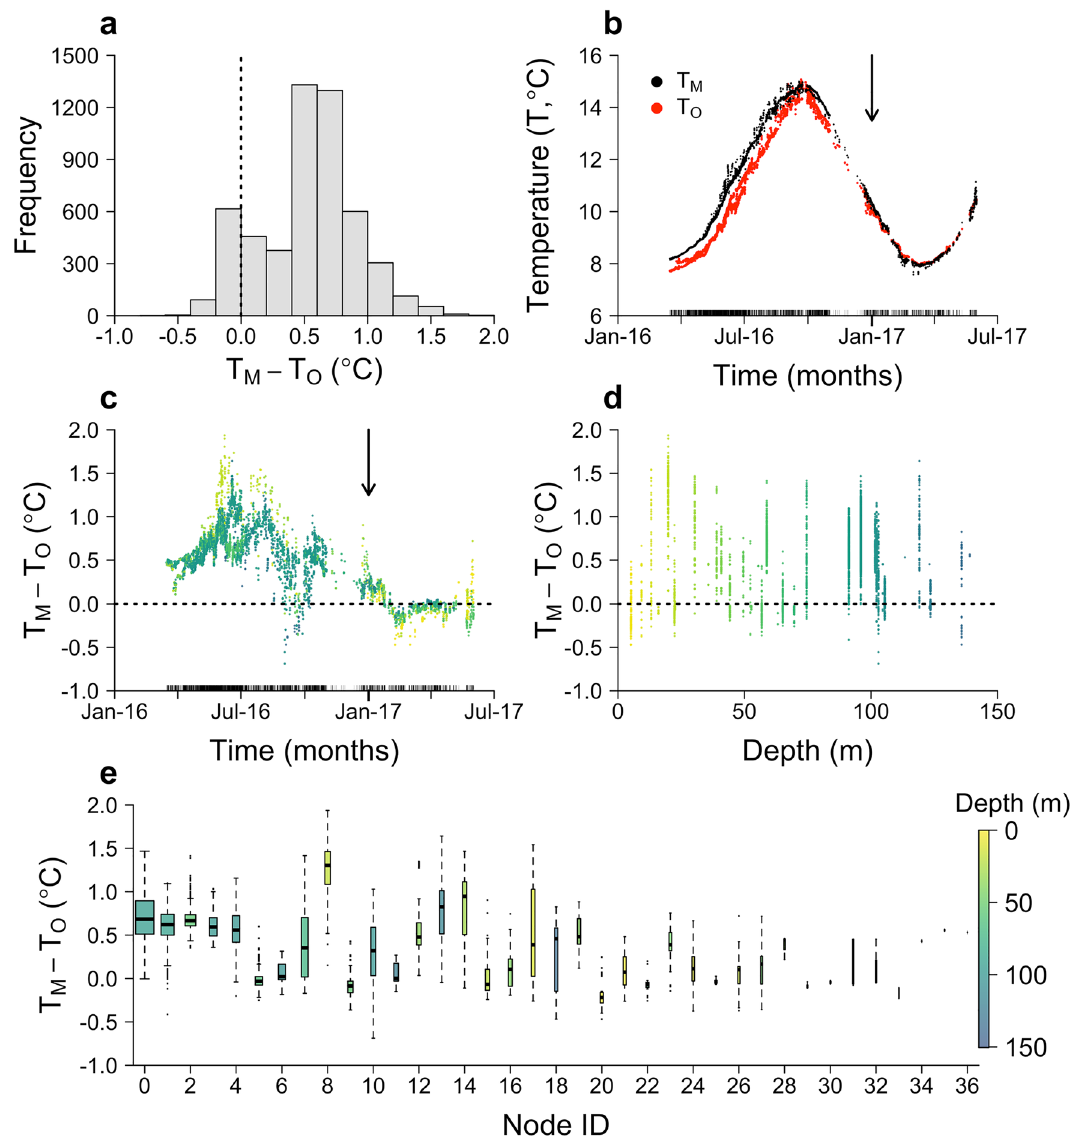
Figure 4. Bottom-temperature validation results. ( a ) The frequency distribution of differences between modelled ( M ) and observed ( O ) bottom temperatures ( T ). The vertical dashed line marks the point of no difference. ( b ) Modelled and observed time series. ( c ) The difference between modelled and observed temperatures through time. In ( b ) and ( c ), the rug marks times with observations and the arrows mark the transition from 2016 to 2017 (when, independently of these observations, the model was upgraded). ( d ) The difference between modelled and observed temperatures in relation to node depth (below mean sea level). ( e ) The difference between modelled and observed temperatures by node (nominally labelled 0, . . . , 36 ; see Supplementary Table S1). For each boxplot, the thick black line marks the median, the edges of the box mark the first ( Q 1 ) and third ( Q 3 ) quartiles and bar ends mark the minimum and maximum values (excluding statistical outliers). Points mark statistical outliers, which are defined as values that are less than Q 1 − 1.5 × IQR or Q IQR respectively, where IQR is the interquartile range. Box width is proportional to the number of 3 + 1.5 × observations (see Supplementary Table